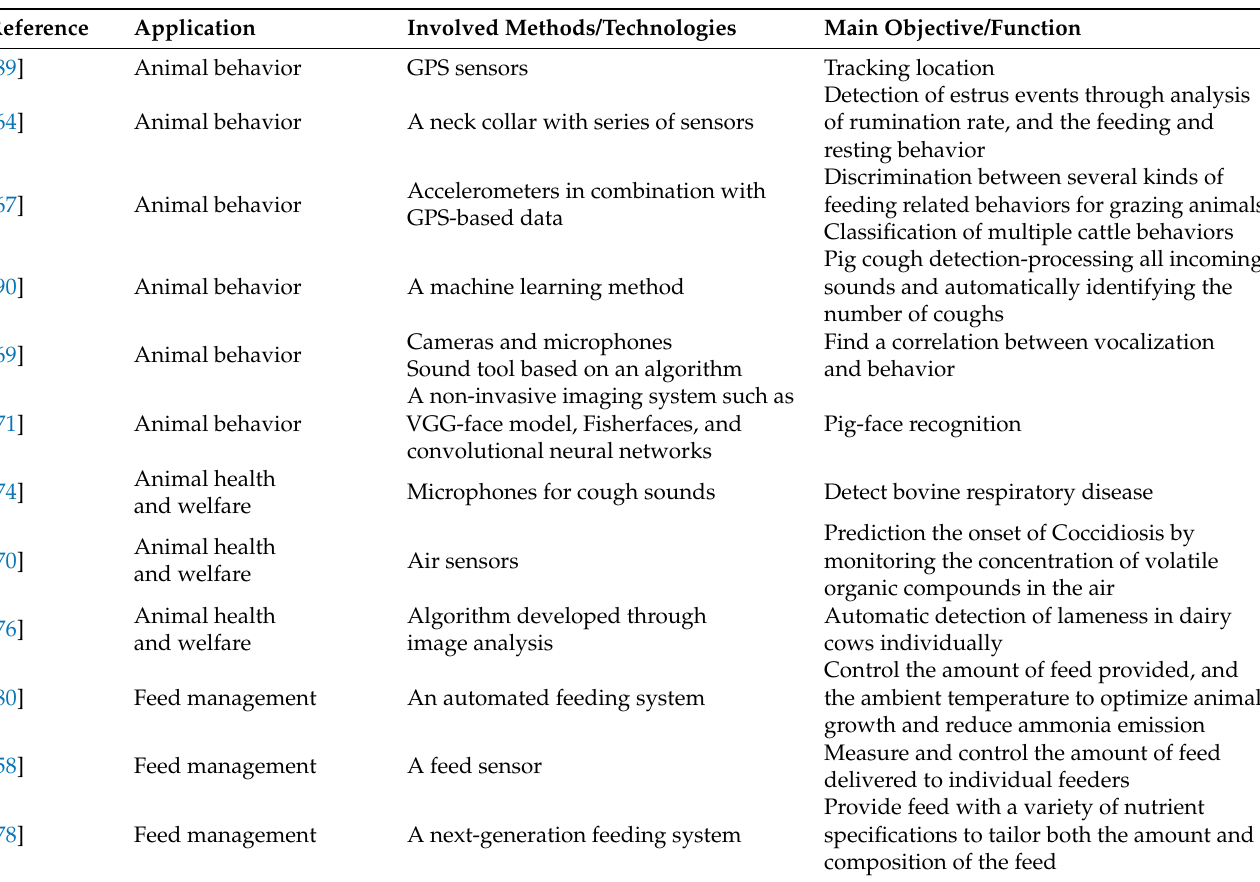
Table 2. Overview of PLF technology and